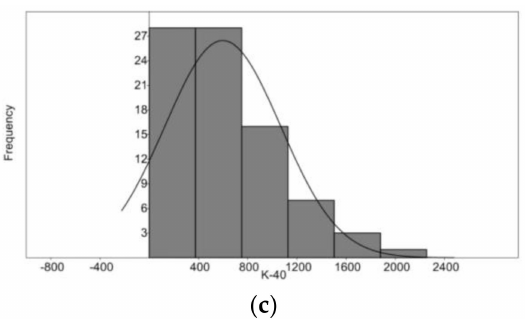
Figure 2. The frequency distribution of the activity concentrations of 226 Ra ( a ), 232 Th ( b ), and 40 K ( c ) in water samples, respectively.